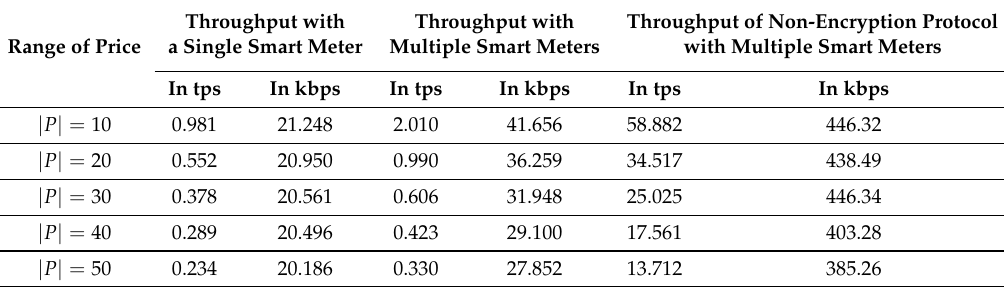
Table 2. Transaction throughput of the proposed protocol.